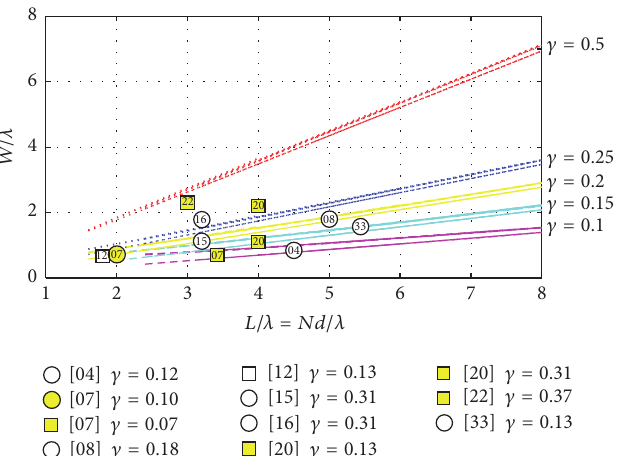
Figure 2: The − 3 dB spot diameter 𝑊 (spot size in the transverse plane at the focal distance) as a function of the array size, 𝐿/𝜆 = 𝑁𝑑/𝜆 , for 0.1 < 𝛾 < 0.5 (see Figure 9 in [2]). The markers denote the performance of NFF arrays described in [4, 7, 8, 12, 15, 16, 20, 22, 33]; the circles and squares are related to simulated and measured results, respectively; for each referenced paper, the empty markers indicate results given by the authors and the filled markers are results extracted from figures. 𝛾 is the focal distance 𝑅 𝐹 normalized to the radius of the far-field region boundary ( 2𝐿 2 /𝜆 ).